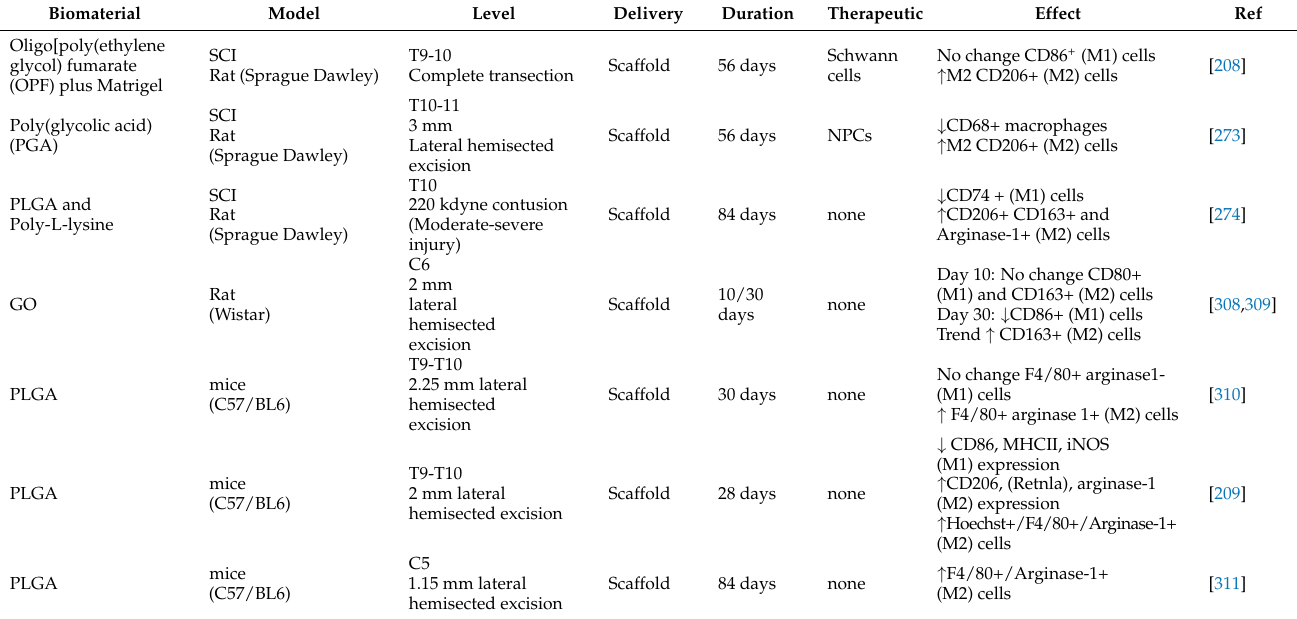
Table 5. Chemical methods that modify macrophage polarization in CNS injury. Where ↑ indicates an increase in specific cells population and ↓ indicates a decrease in specific cell